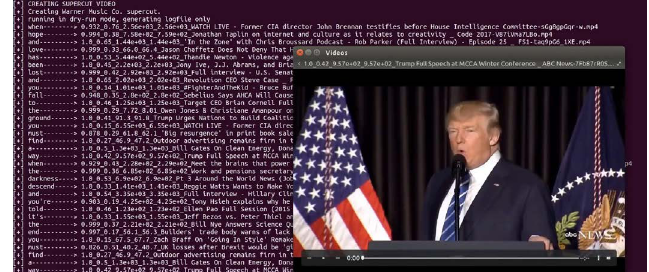
Figure 3: Branger_Briz (Ramon Branger, Paul Briz, Nick Briz, Brannon Dorsey and Pedro Nel Ovalles), Muse AI Supercut (2017). Project case study screenshot. Image courtesy of